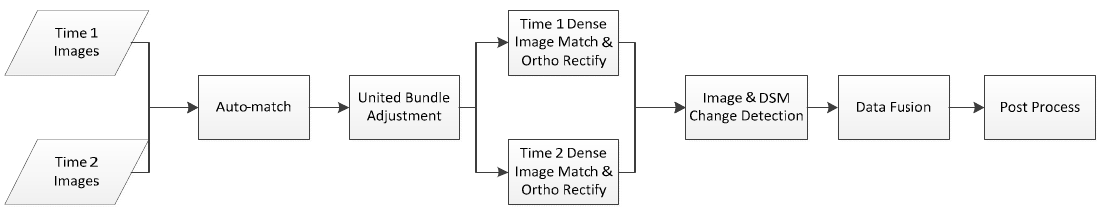
Figure 2. A workflow chart of united bundle adjustment-based change detection.